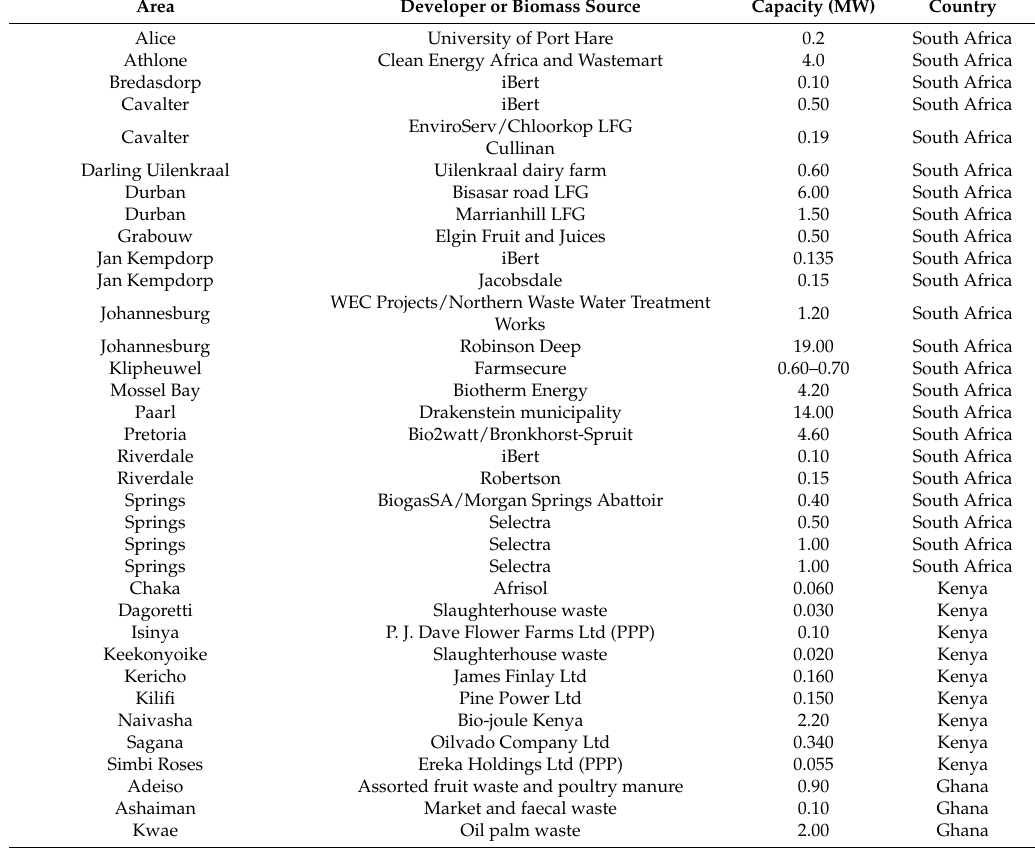
Table 1. Example of commercial Biogas digesters in some African Countries